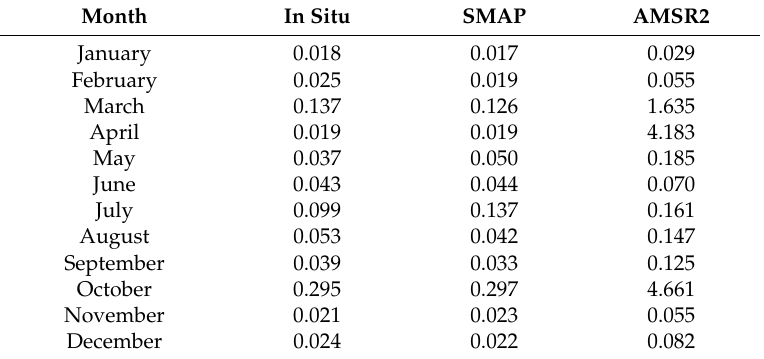
Table 4. Estimated errors of the in situ, SMAP, AMSR2 soil moisture dataset for monthly average with the TC method. Month In Situ